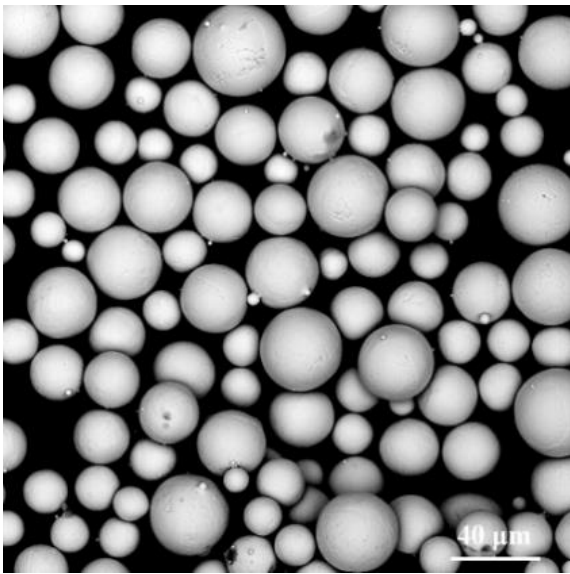
Figure 2. SEM images of TC4 metal powder morphology. Table 1. Chemical composition of TC4 metal powder.